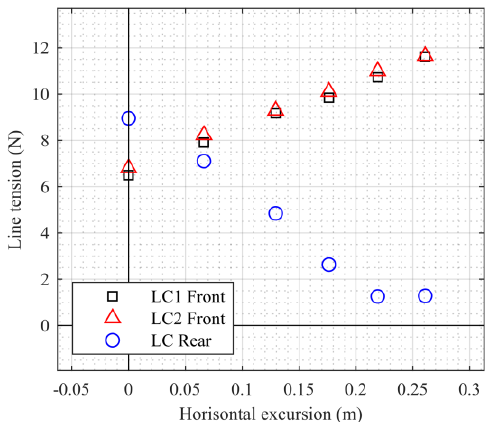
Figure 11. Relation between horizontal excursion and mooring line tension for the compliant mooring system.